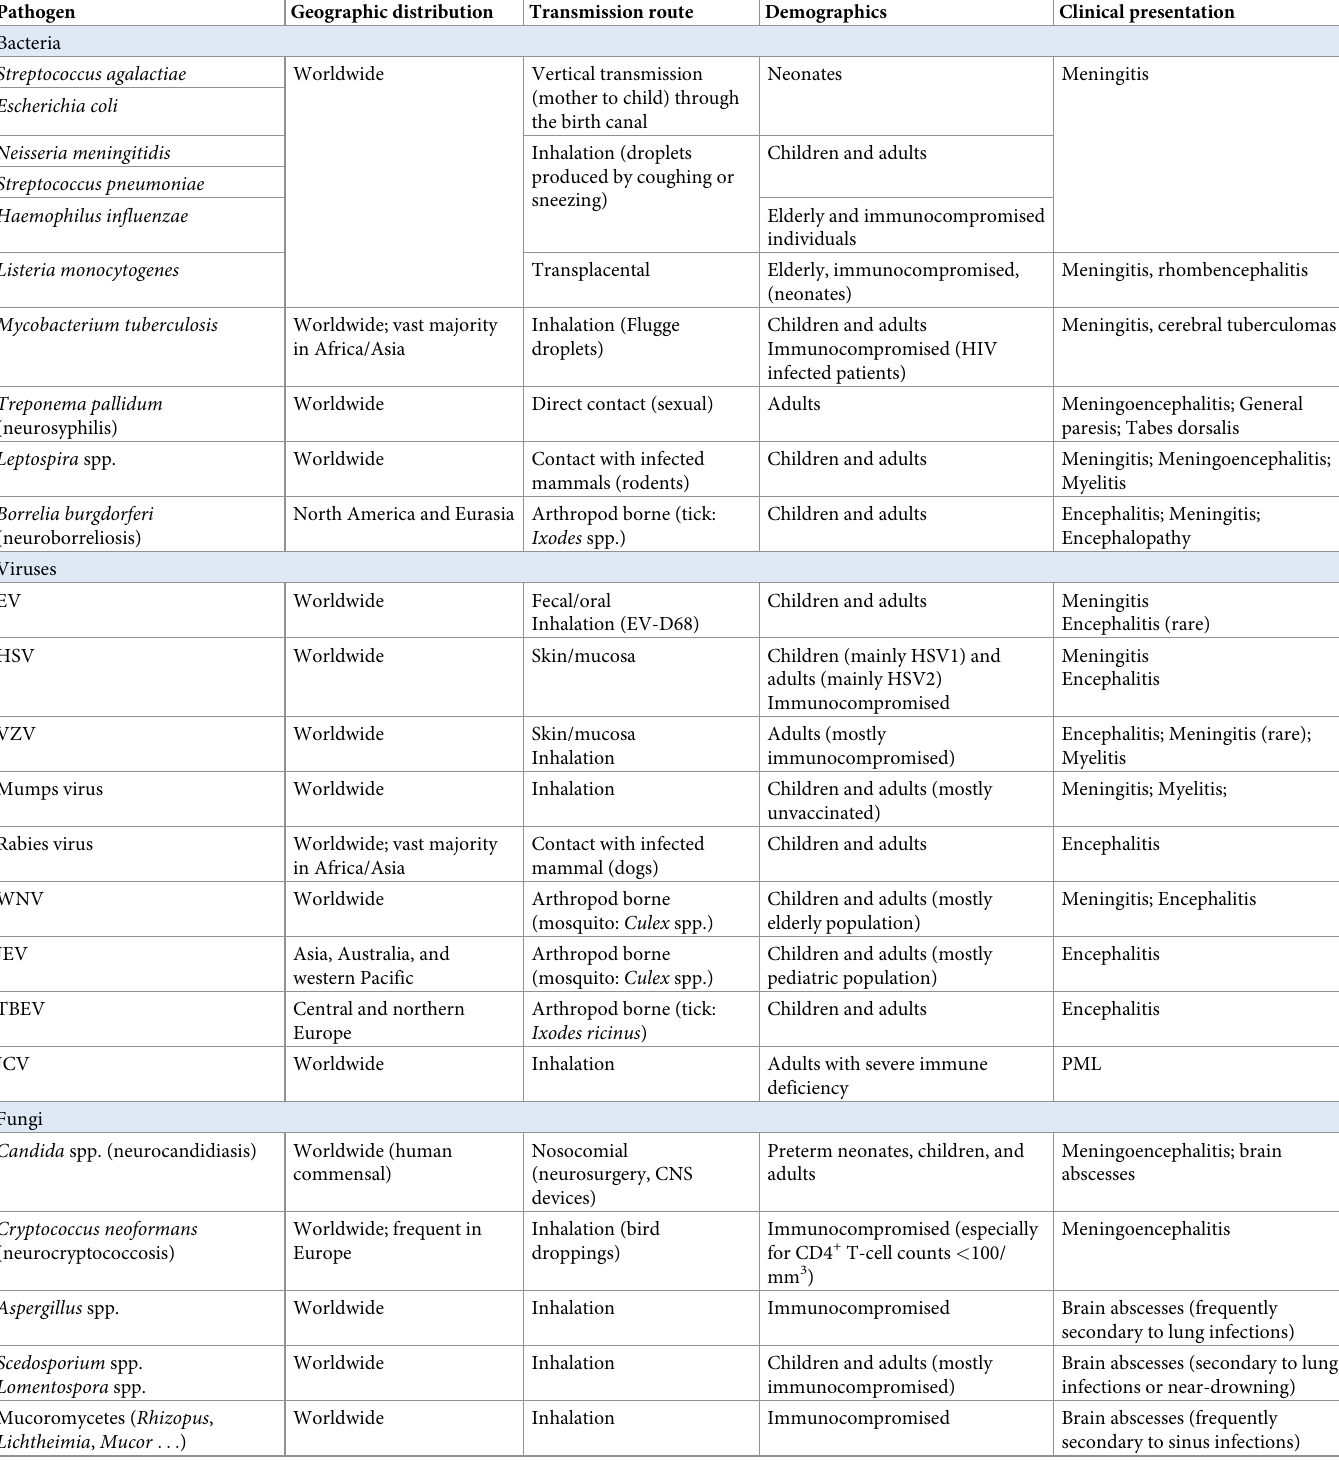
Table 1. Etiology and epidemiology of CNS